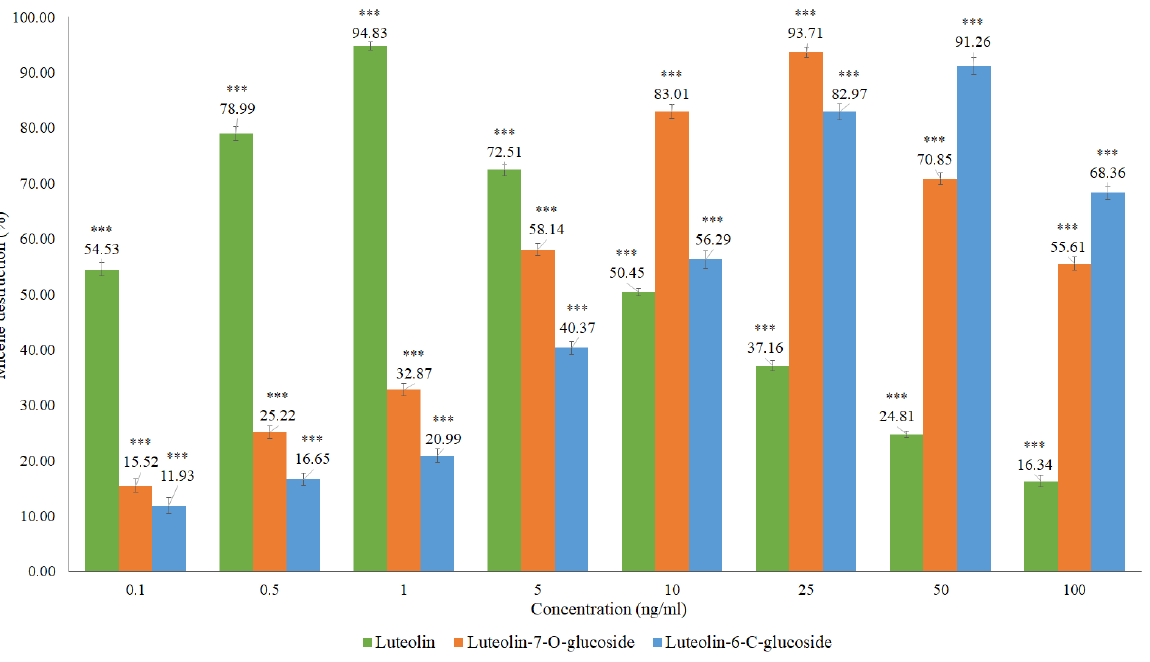
Figure 8. In vitro cholesterol micellar solubility assay for luteolin, luteolin-7- O -glucoside, and luteolin-6- C -glucoside (isoorientin). The results are expressed as the mean ± standard deviation (minimum of three independent assays, performed in triplicate). The control micelle destruction value was 100%. The statistical tests were performed with *** p < 0.05 compared to the control. Micellar inhibition was observed for the flavonoids analyzed, with the luteolin show- ing a higher percentage of micelle destruction at a lower concentration compared to the flavonoids in glycosylated form, luteolin-6- C -glucoside (isoorientin) and luteolin-7- O -glu- coside. Luteolin presented a percentage of micelle destruction of 94.83% in the concentra- tion of 1 ng/mL, followed by luteolin-7- O -glucoside with 93.71% for 25 ng/mL and luteo- lin-6- C -glucoside with 91.26% in the concentration of 50 ng/mL. Flavonoids in glycosyl- ated form are hardly absorbed in the small intestine due to their hydrophilic characteris- tics. These compounds are supposed to pass directly through the small intestine, being hydrolyzed by enterobacteria and releasing the corresponding genin. Non-glycosylated flavonoids can be absorbed more easily by epithelial cells of the large intestine due to their lipophilicity, which facilitates the passage through the phospholipid layer of the cell mem- brane [30]. The results of this research demonstrate the potential of Cymbopogon citratus and of the flavonoids such as luteolin and its glycosylated forms in inhibiting intestinal cholesterol absorption. Other studies have already shown that polyphenols, namely the black tea polyphenols such as theaflavin, theaflavin-3-gallate, theaflavin-3 ’ -gallate, theaflavin-3,3 ’ -digallate, and theaflavin-monogallates can currently be effective to de- crease the plasma cholesterol concentration, inhibiting cholesterol absorption in the intes- tine, with at least part of the inhibition being attributed to the diminished micellar solu- bility of cholesterol [21]. Black tea polyphenols have cholesterol-lowering activity in hu- mans, suppressive activity of postprandial hypertriacilglycerolemia in rats, and in vitro preventive activity in the oxidation of low-density lipoproteins (LDL) [31 – 33]. Other in vivo and in vitro studies have shown the existence of a change in the absorp- tion of cholesterol, not by micellar destruction but by the inhibition of the epithelial cho- lesterol transporter Niemann – Pick C1-Like 1 (NPC1L1) by the action of flavonoids [9]. The study focused on the effect of luteolin and quercetin on cholesterol absorption medi-